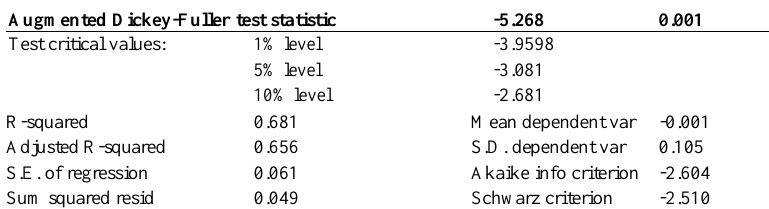
Table 4. Stationarity estimations of the first differences of the ln (INC) series by